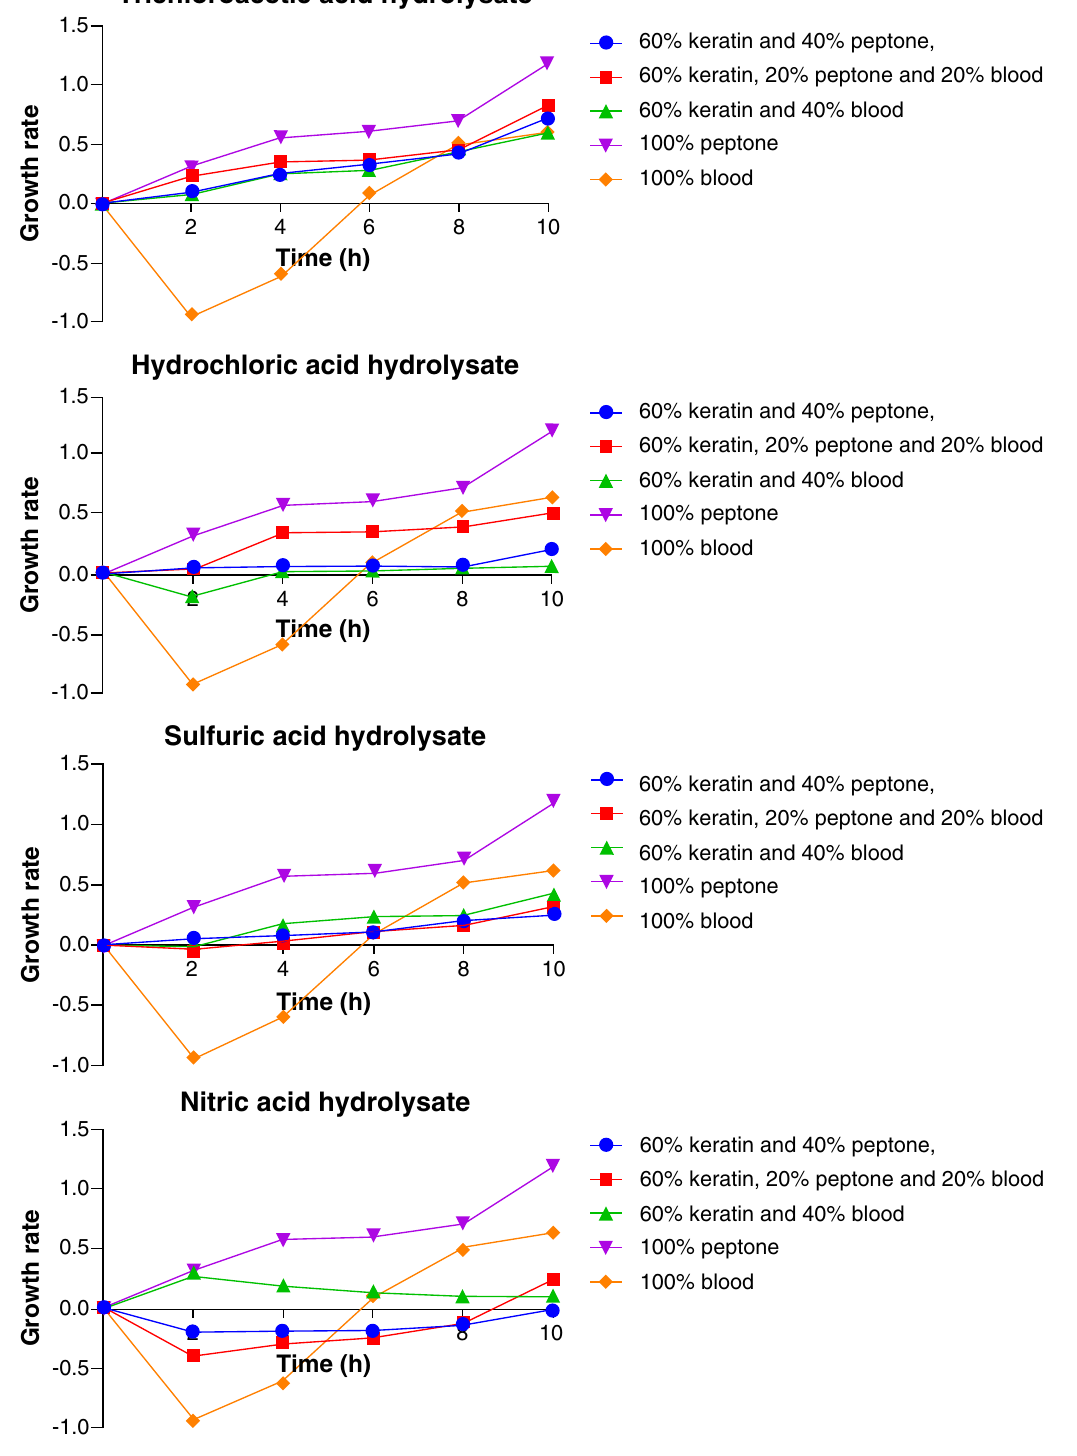
SO and HNO 2 4 3